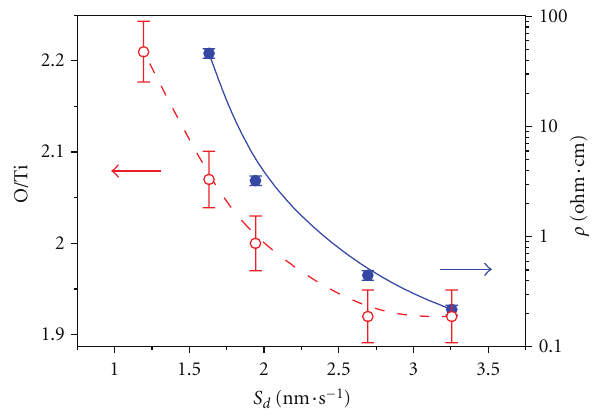
Figure 9: Electrical resistivity ρ at room temperature and the atomic ratio of O/Ti versus deposition rate S d for TiO 2 − y thin films prepared by reactive sputtering. Lines are guides to the